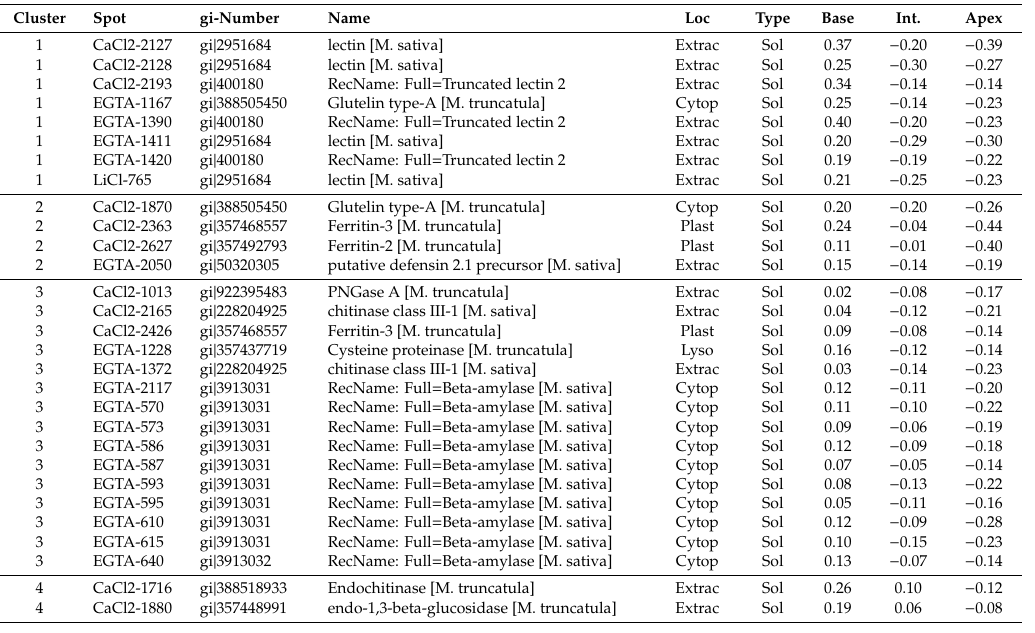
Figure 1. Principal component analysis (PCA) showing the distribution of the individuals based on the set of 113 proteins differentially regulated in the different stem regions. Only the two first components are represented (PC1: 55.98%, PC2: 10.24%). Each dot refers to one replicate and squares represent the barycenter of the dots corresponding to one stem region. Table 1. Clustering of the proteins according to the procedure described in the method section: By stem region (basal part (Base); intermediate part (Int); apical part (Apex) of the stem), the average abundance measured for each spot is given as log(2) of the standardized volume and represented by a green bar. The column “Loc” and “Type” respectively indicate the localization and protein type (soluble (Sol) and membranair (Memb)), as predicted by Deeploc. Extracellular (Extrac); cytoplasmic (Cytop); plastidial (Plast); Lysosomal / vacuolar (Lyso). Detailed identification data are given in Supplementary Table S1A for the CaCl 2 fraction, Supplementary Table S1B for the EGTA fraction, and Supplementary Table S1C for the LiCl fraction. The functional classification of the spots that contribute significantly to two PCA dimensions are given in Supplementary Table